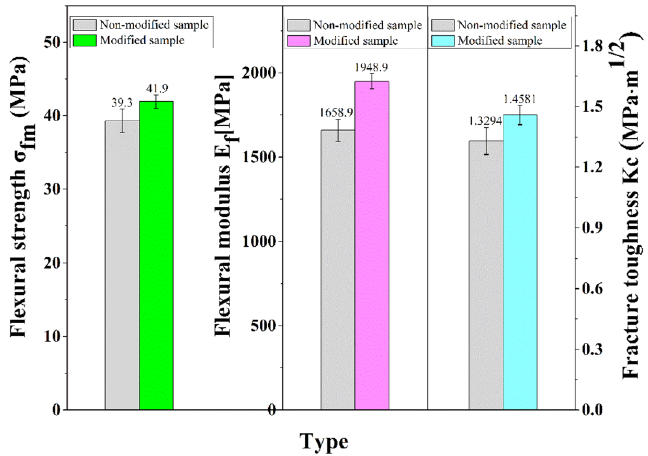
Figure 4. Flexural strength, flexural modulus and fracture toughness of the non-modified and modified SS/PU